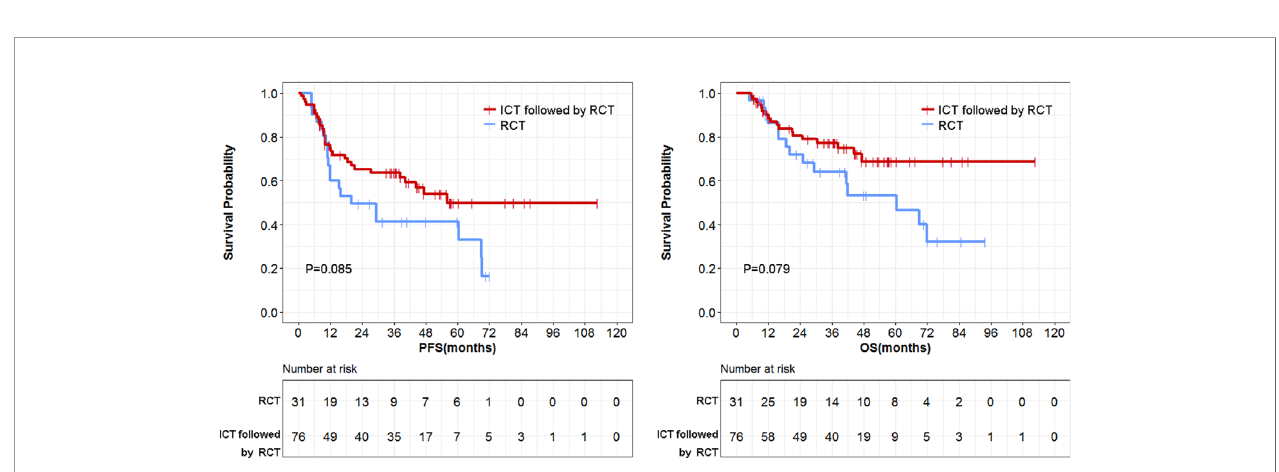
FIGURE 6 | Comparison of survival data between induction chemotherapy/radiotherapy (CT/RT) group and concurrent CT/RT